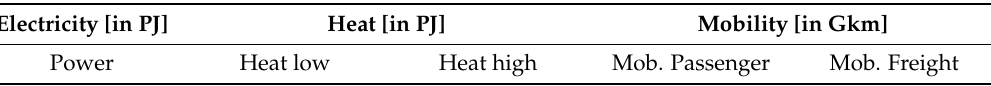
Table 1 . Fuel disaggregation. Table 1. Fuel